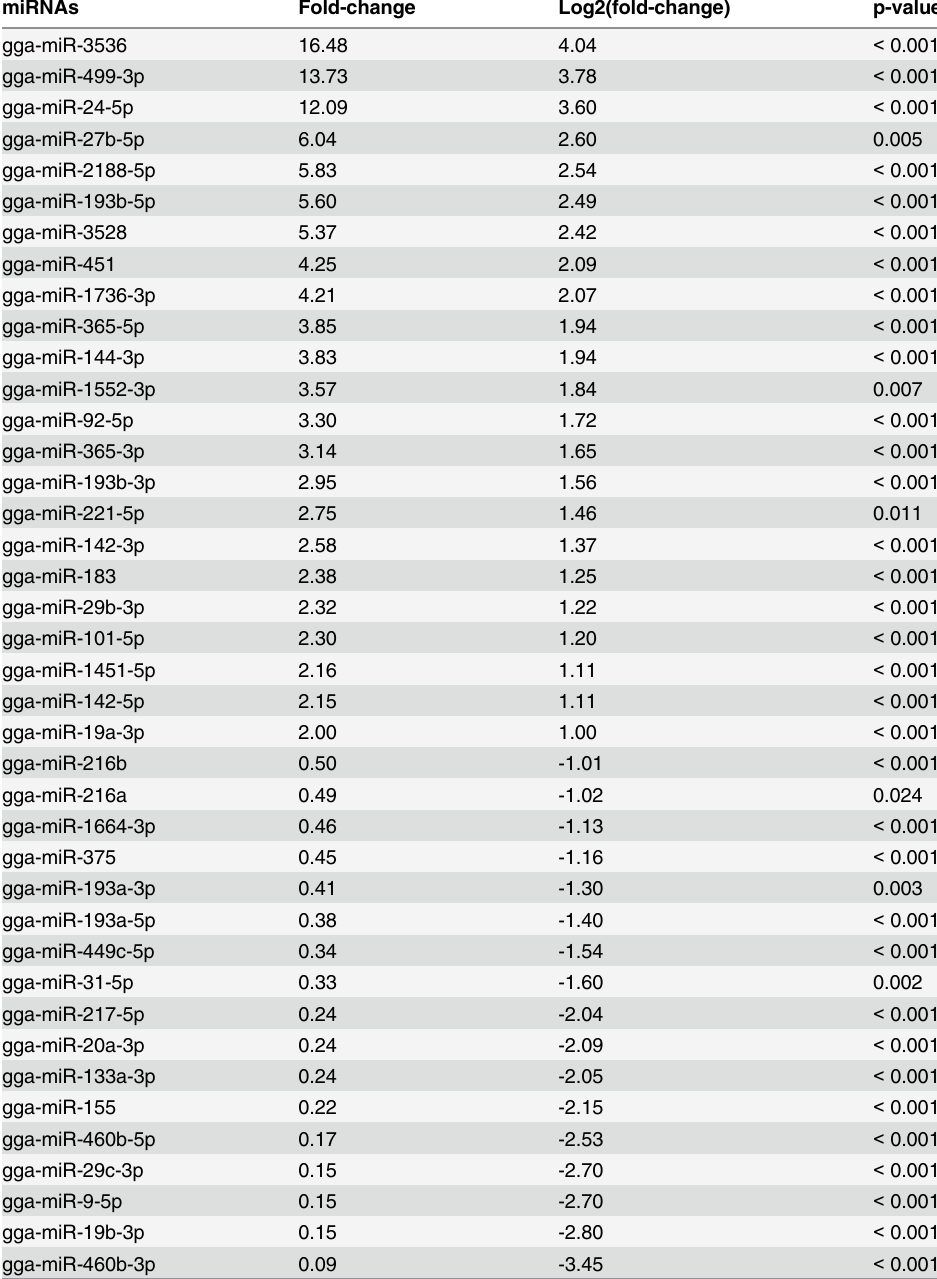
Table 1. The differentially expressed serum-miRNAs with more than two fold-changes between BO and